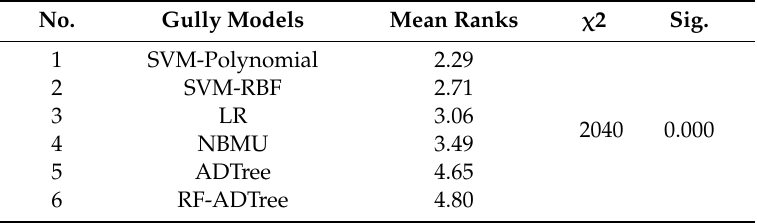
Table 5. Average ranking of the five gully erosion models for the study area using the Friedman’s test. No. Gully Models Mean Ranks χ 2 Sig.